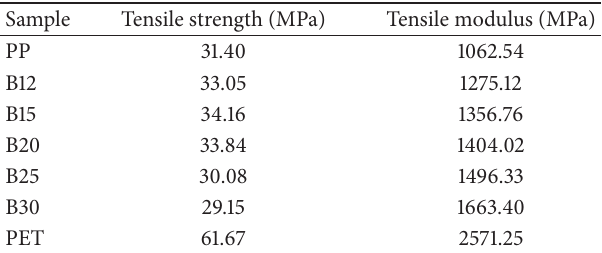
Table 7: Tensile strength and tensile modulus of PP, PET and PP/PET